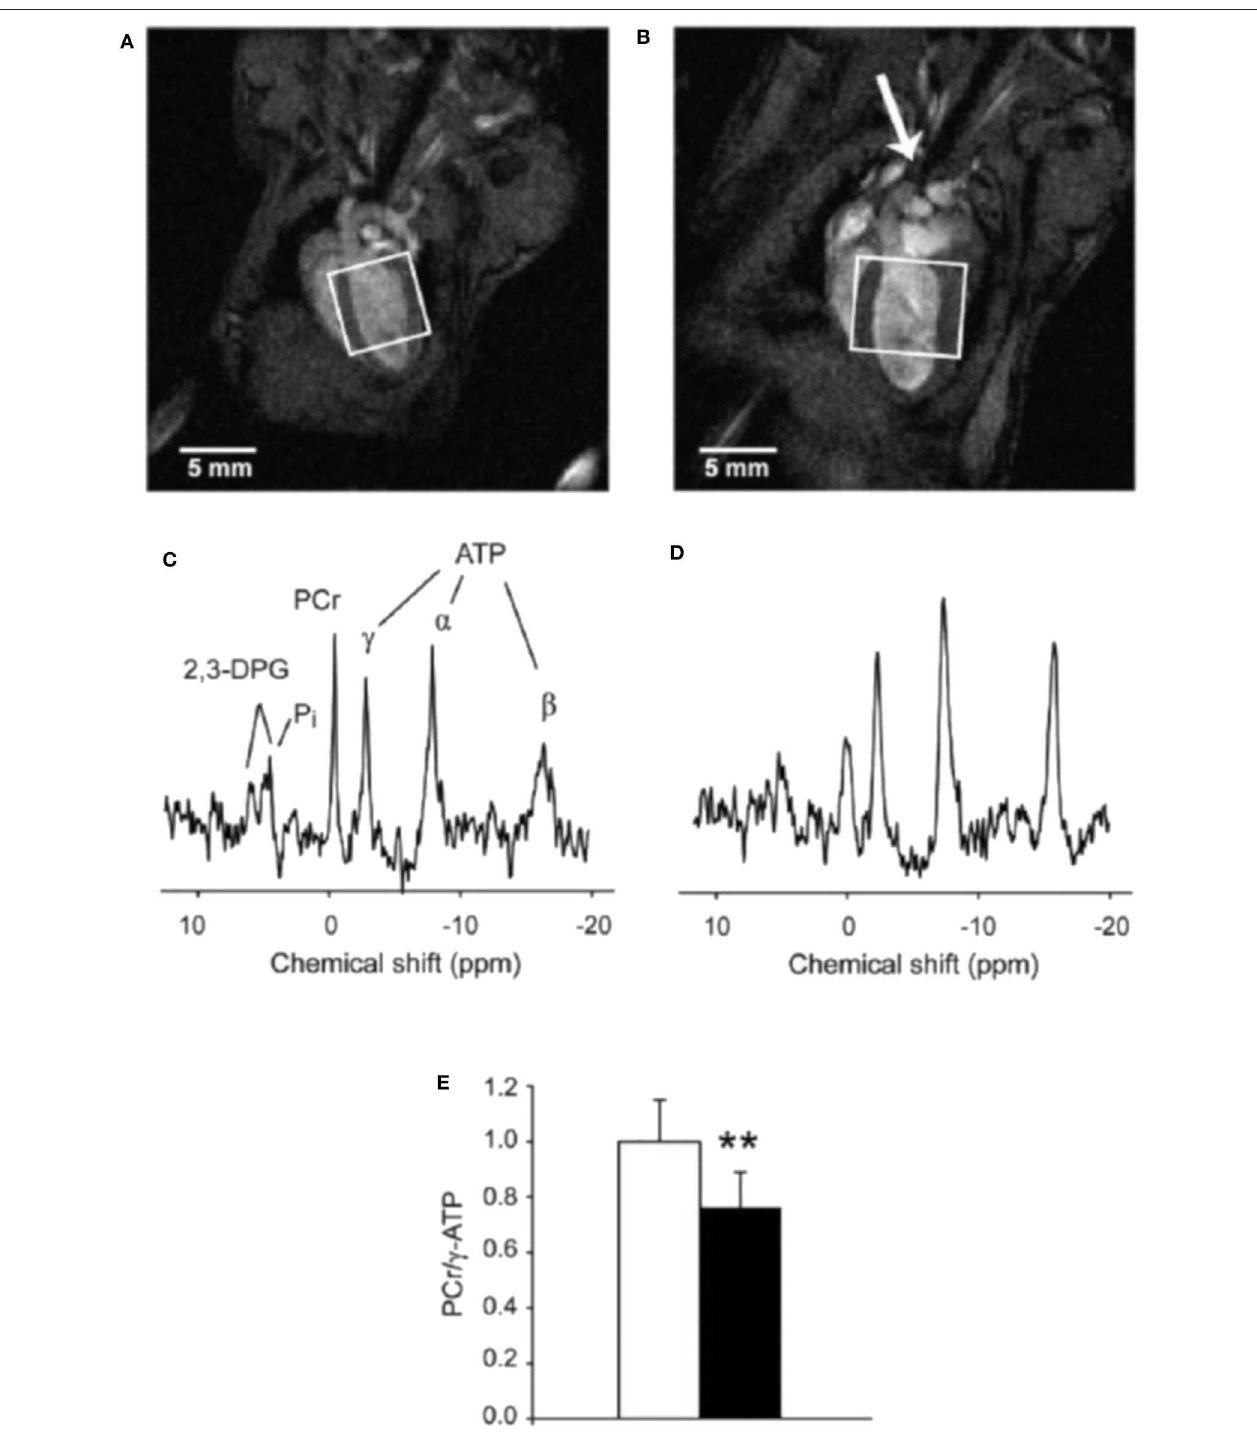
FIGURE 13 | End-diastolic left ventricular MR images obtained from a control mouse (A) and a mouse with a transverse aortic constriction (TAC) (B) . The constriction is indicated by the arrow. Dilated hypertrophic cardiomyopathy is evidenced by increased LV wall thickness and LV cavity volume in the TAC mouse. Rectangles indicate the voxels selected for localized 31P-MRS with 3D ISIS. (C,D) display 31 P MR spectra acquired in vivo with 3D ISIS in a healthy mouse heart and a TAC heart, respectively. Myocardial PCr/ γ -ATP was lower in TAC mice ( n = 8) compared to healthy controls ( n = 9) (E) . Data are expressed as mean ± SD. ** P < 0.01. α -, β -, γ -ATP, α -, β -, and γ -phosphate groups in ATP; 2,3-DPG, 2,3-diphosphoglycerate; PCr, phosphocreatine; Pi, inorganic phosphate. Reproduced with permission from Bakermans et al. [203].